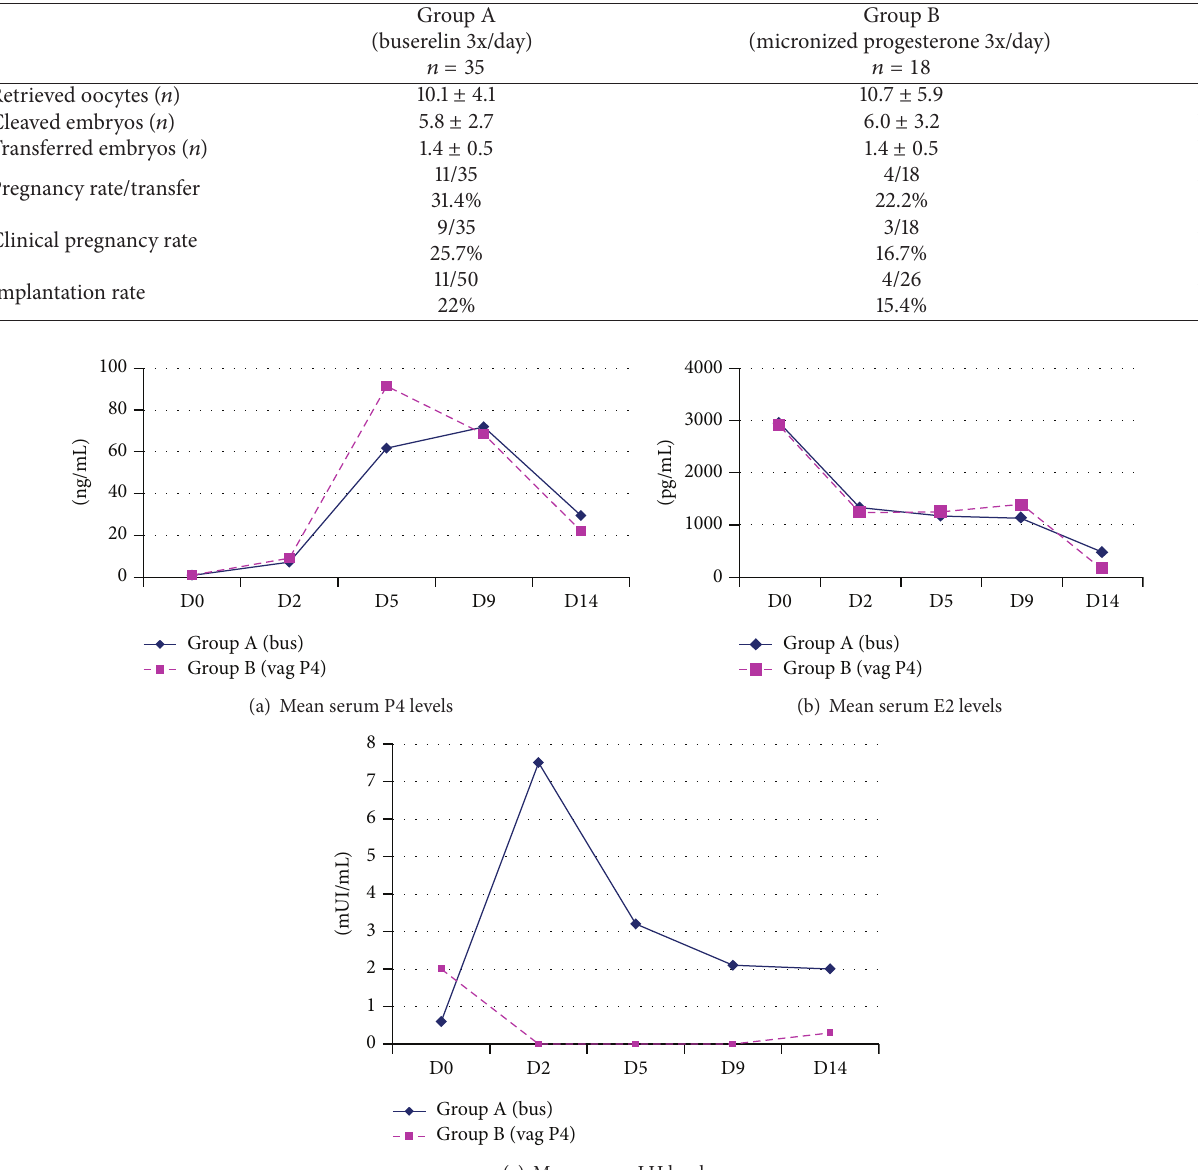
Figure 2: Hormone levels during the luteal phase on D0 (day of ovulation trigger), D2, D5, D9, and D14. (a) Mean progesterone levels. (b) Mean estradiol levels. (c) Mean LH